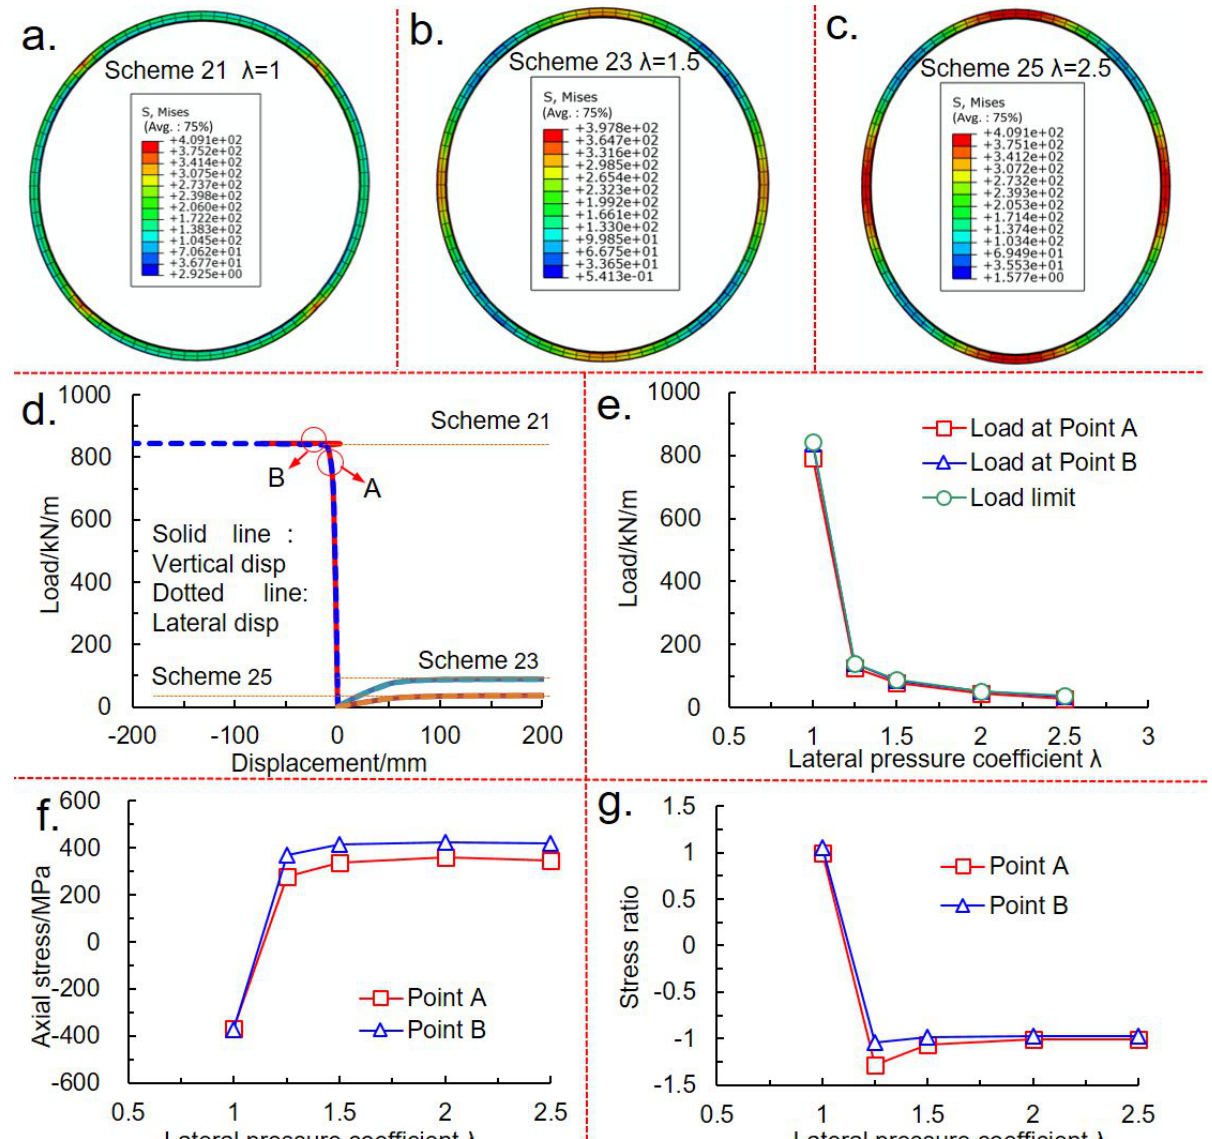
Figure 10: Typical results for Schemes 21–25 with the different lateral pressure coeflcients. (a)–(c) Stress contours and deformed shapes of the arches; (d) Load-displacement curves; (e) Characteristic loads influenced by the lateral pressure coeflcient; (f) Axial stress at the dangerous section, influenced by the lateral pressure coeflcient; (g) Ratio of the axial stress at the inner and outer sides of the dangerous section, influenced by the lateral pressure